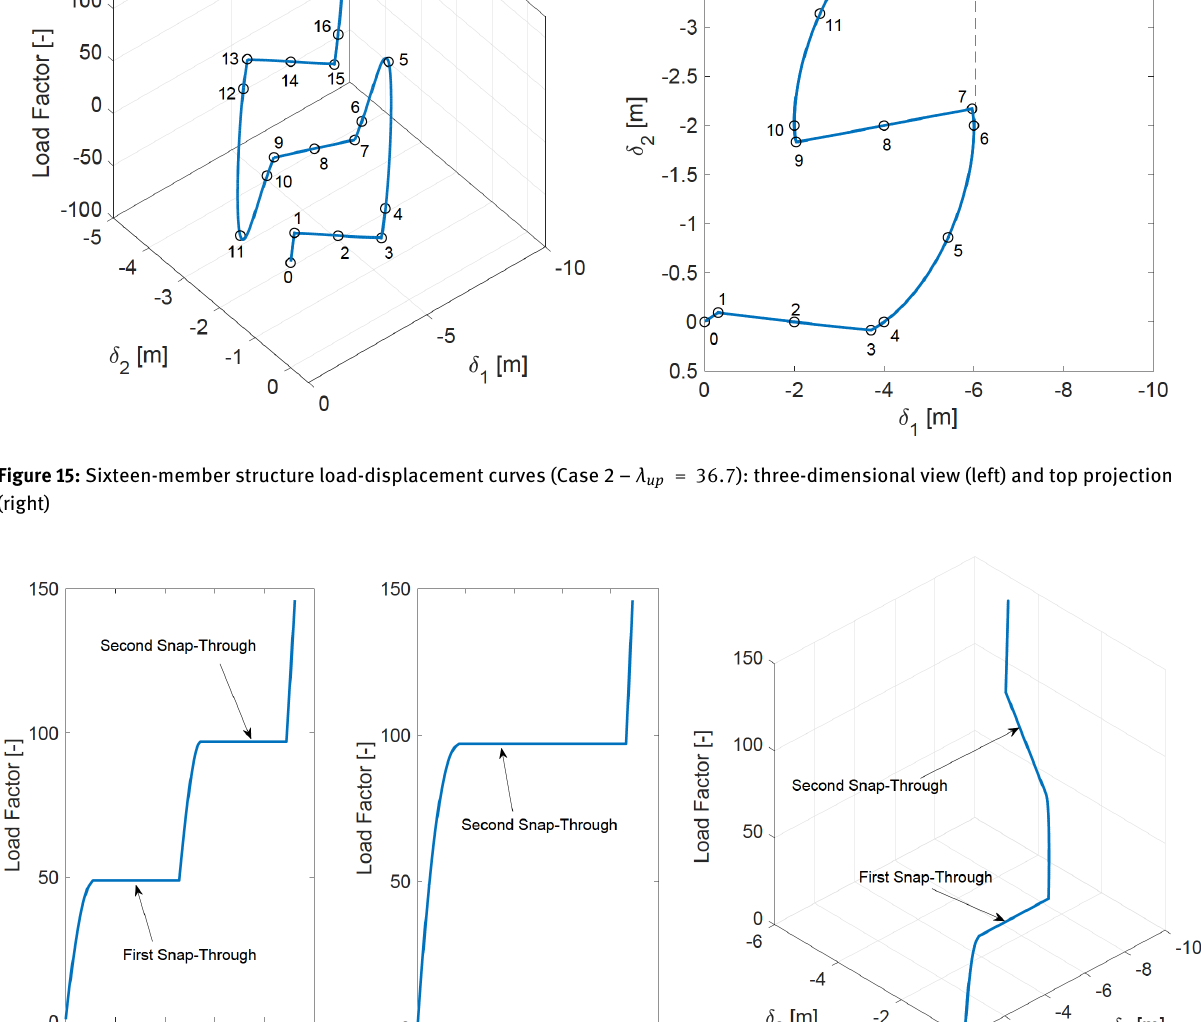
sequences, involving two subsequent snap-through phe- nomena (Figures 16 and